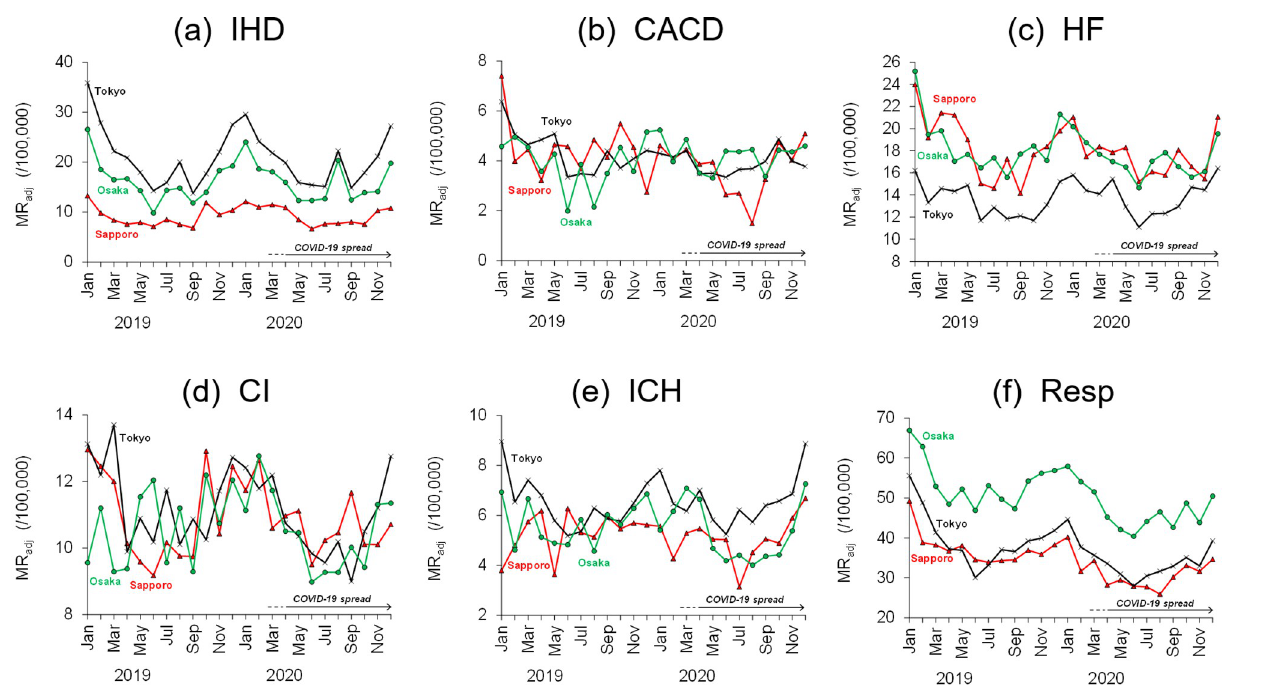
Fig 3. Monthly variations of each MR adj from 2019 to 2020. Mortality rates of (a) acute ischaemic heart disease (IHD), (b) cardiac arrhythmia and conduction disorder (CACD), (c) heart failure (HF), (d) cerebral infarction (CI), (e) intracerebral haemorrhage (ICH), and (f) respiratory diseases (Resp) are shown for Sapporo, Tokyo, and Osaka. In Japan, COVID-19 began to spread in March 2020 (cf. Fig 2).